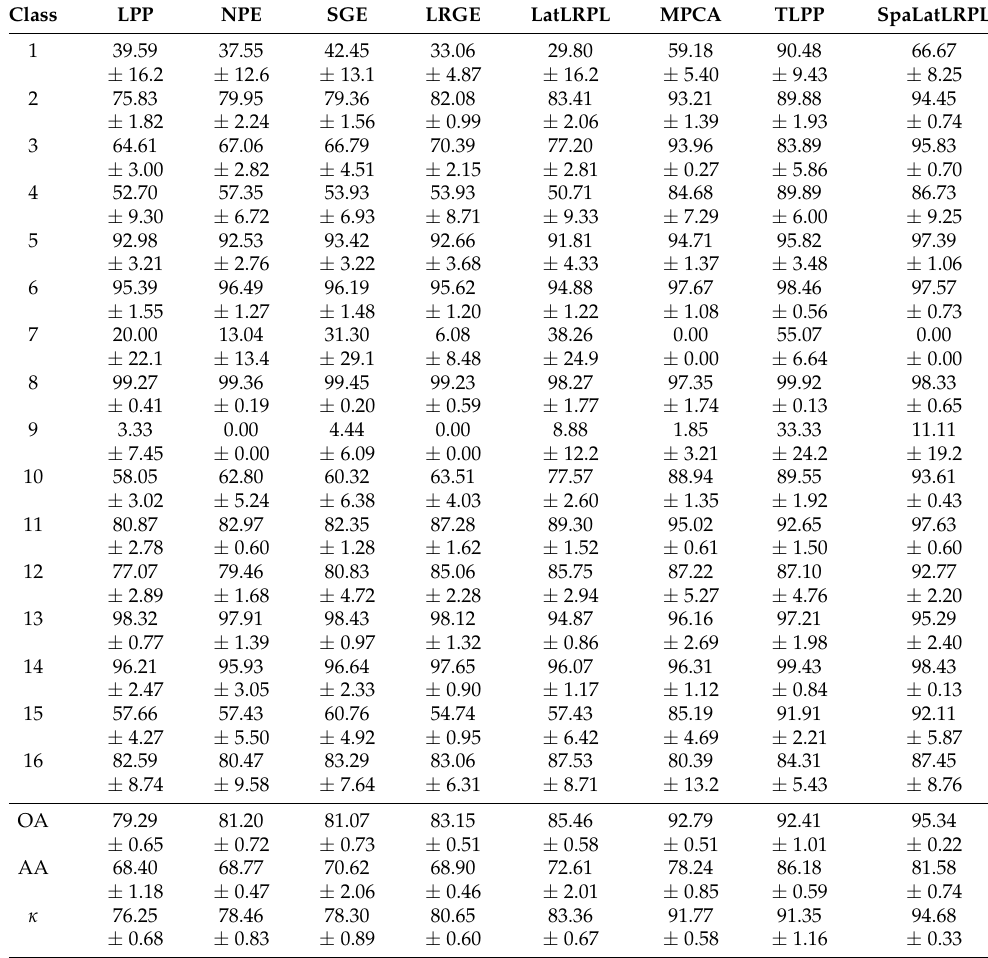
Table 1. The comparison of performance for all methods on the Indian Pines